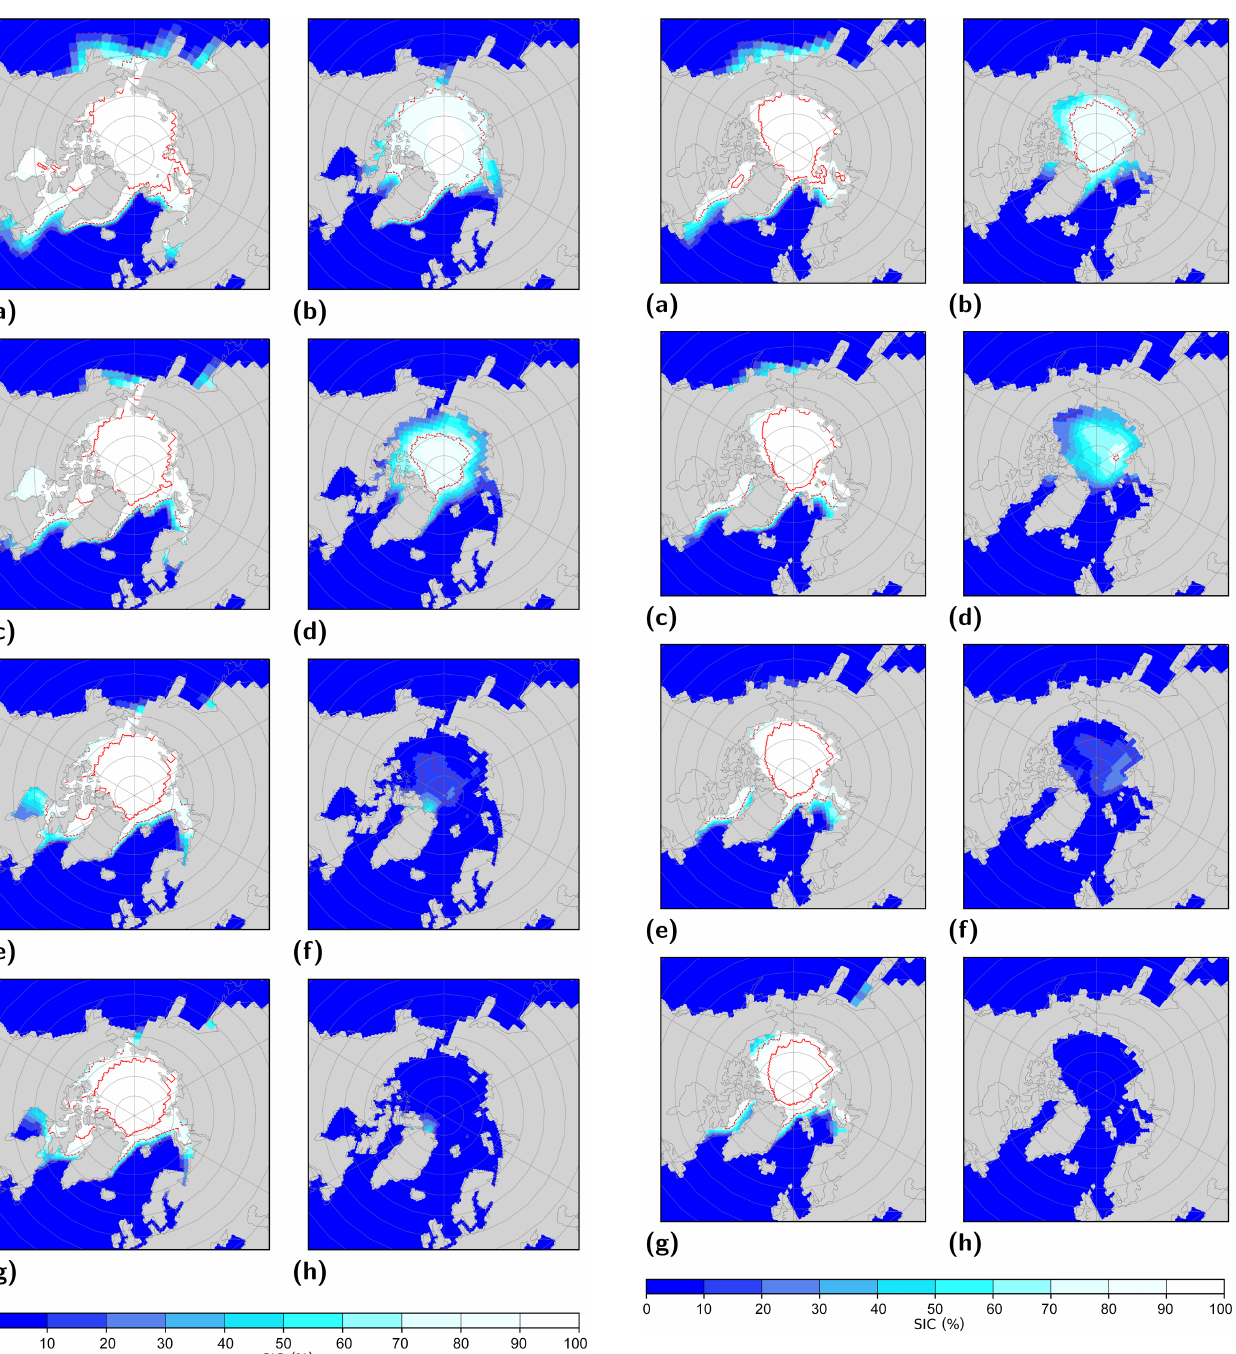
Figure 15. Sea ice coverage (SIC) in the Northern Hemisphere for boreal spring (MAM, a, c, e, g ) and boreal autumn (SON, b, d, f, h ) depending on the volume mixing ratio of carbon dioxide for mid- Pliocene geography. Shown are (a, b) Eoi280, (c, d) Eoi350, (e, f) Eoi450, and (g, h) Eoi560. Grey shading illustrates the land– sea mask. Red contours illustrate SIC isolines of 15% (dotted), 75% (dashed), and 95%